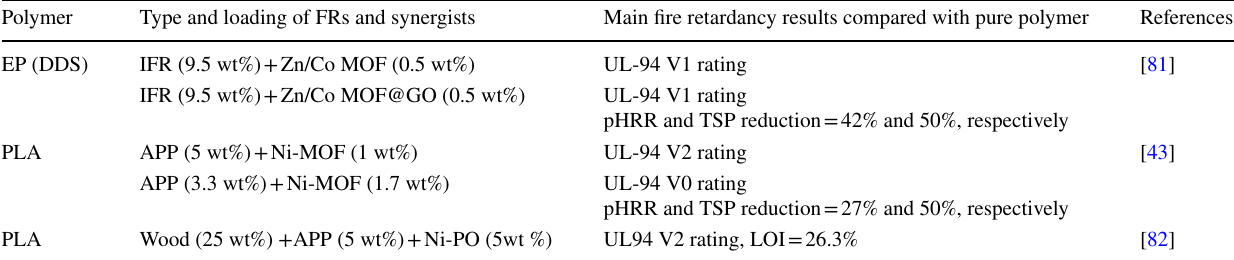
Table 3 Summary of MOF‑based synergists on flame retardancy of polymer composites Polymer